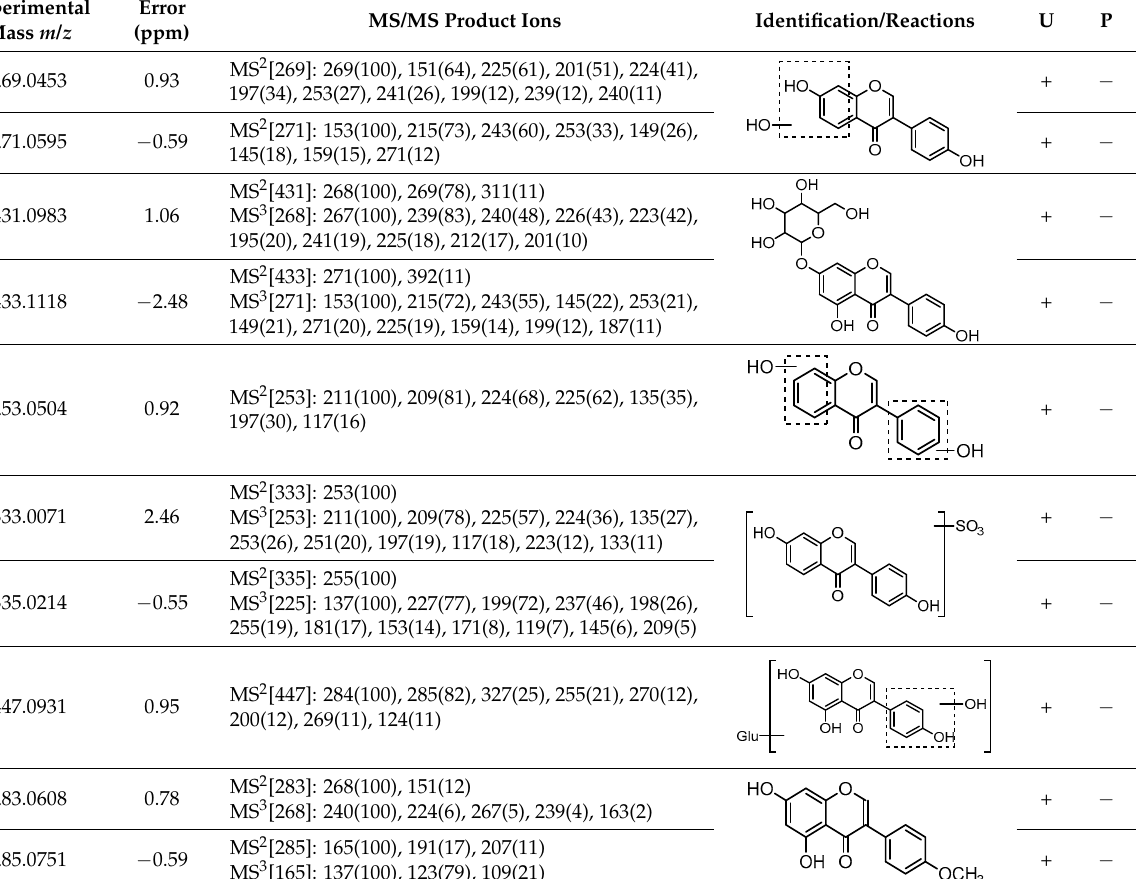
Table 1. Summary of daidzein metabolites in rat urine and